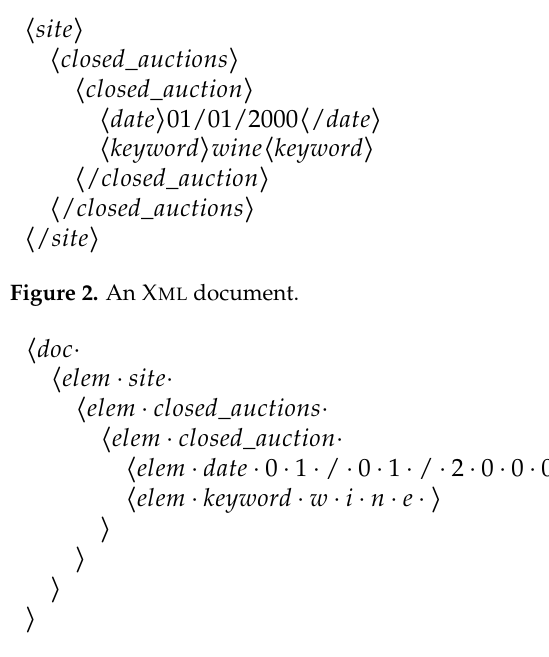
Figure 3. The corresponding nested word.